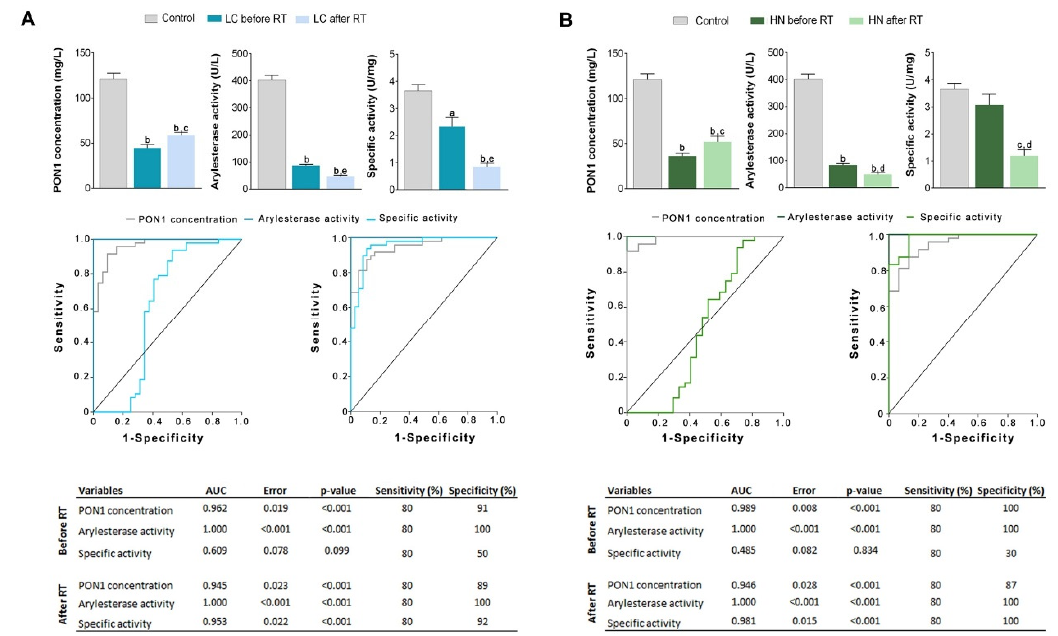
Figure 1. Serum paraoxonase-1 (PON1) concentration, arylesterase (ARE) activity, PON1 specific activity, and receiver operating characteristics (ROC) curves in patients with ( A ) lung cancer (LC) or ( B ) head and neck cancer (HNC) before and after radiotherapy (RT). Results are shown as means and standard errors. a p < 0.01, b p < 0.001, with respect to the control group; c p < 0.05, d p < 0.01, e p < 0.001, with respect to pre-radiotherapy, by the Mann-Whitney U -test. Table 2. Binary logistic regression analyses of selected variables showing their significant and independent association or not with the presence or absence of cancer. Model